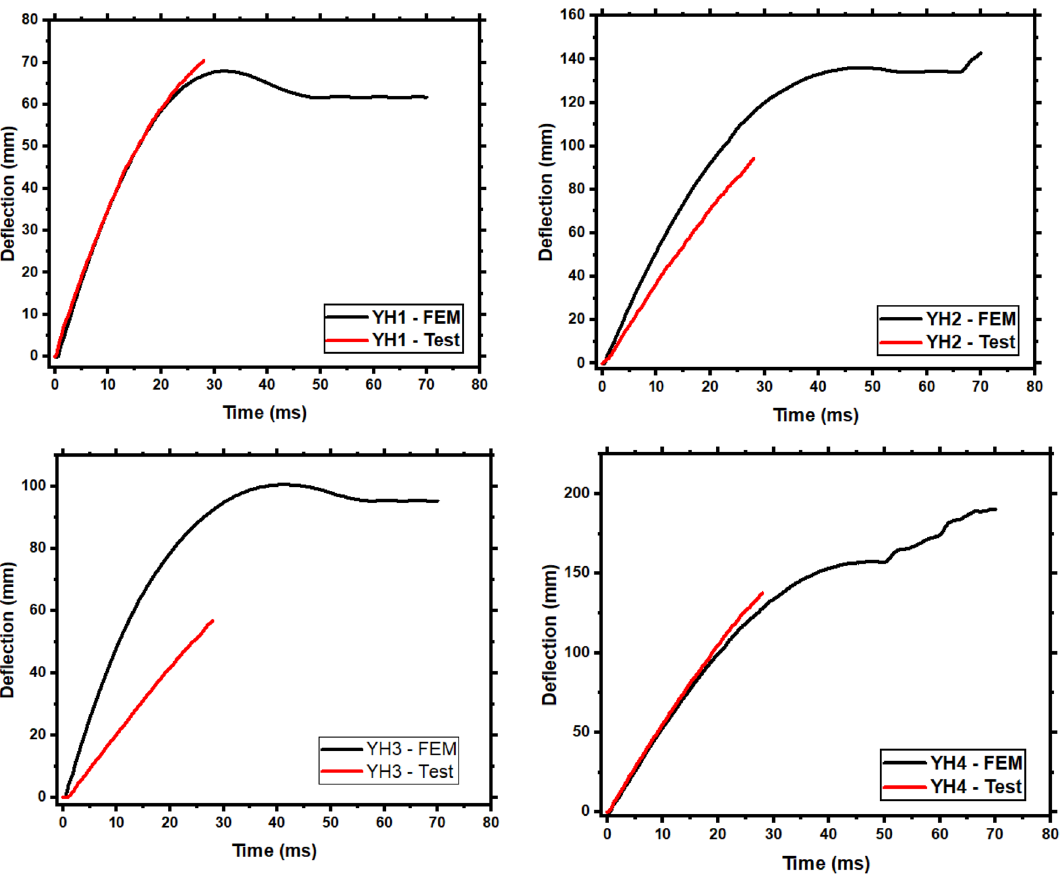
Figure 7. Comparison of deflection time history